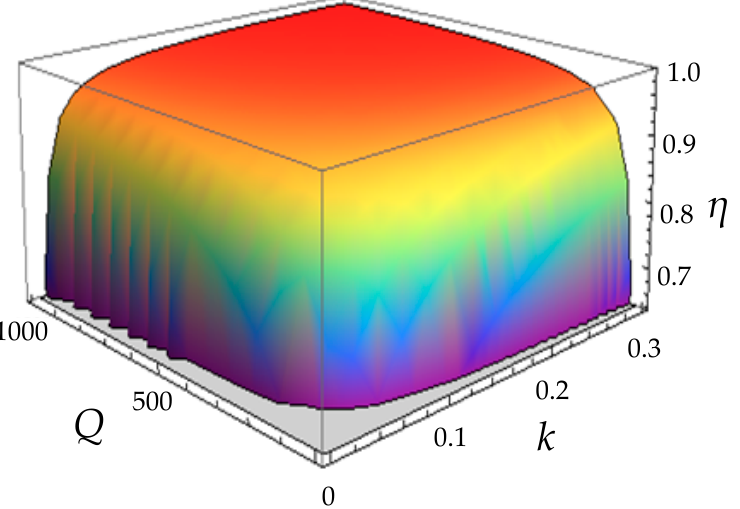
Figure 10. Relationship between k – Q and transmission efficiency.